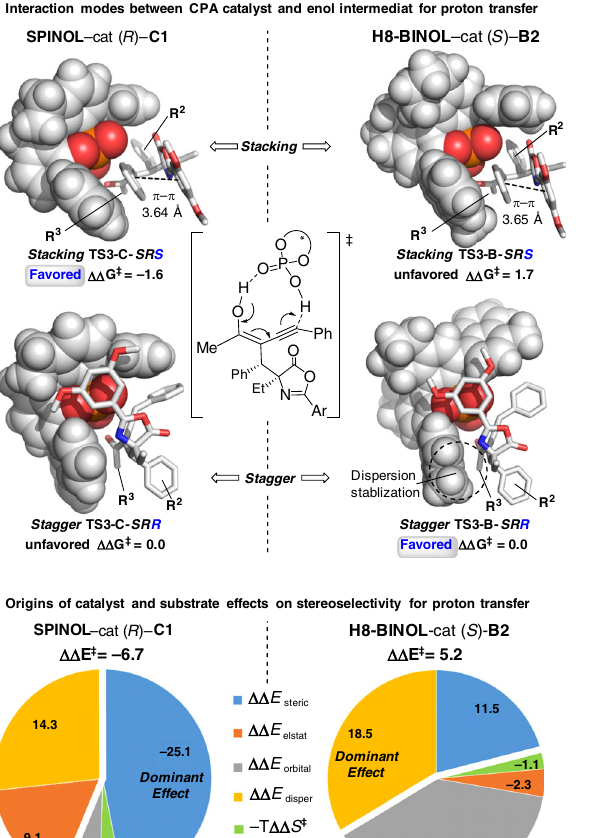
Table 2 Calculated free energies of activation for proton transfer transition states for substrates with different R 2 /R 3